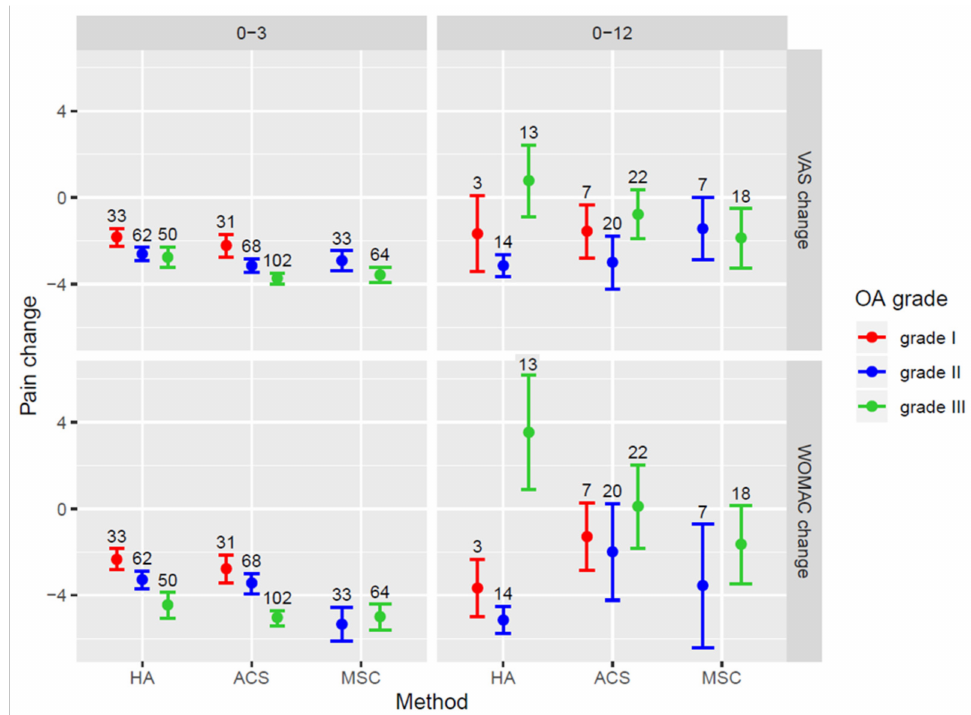
Figure 4. Forest plot showing VAS and WOMAC score changes in patients with different OA grades for the patient groups treated with separate treatment methods. Mean values of score change ± SEM are presented. OA = osteoarthritis; VAS = Visual Analogue Scale; WOMAC = Western Ontario and McMaster Universities Osteoarthritis Index. HA = hyaluronic acid; ACS = autologous conditioned serum; BMAC = bone marrow aspirate